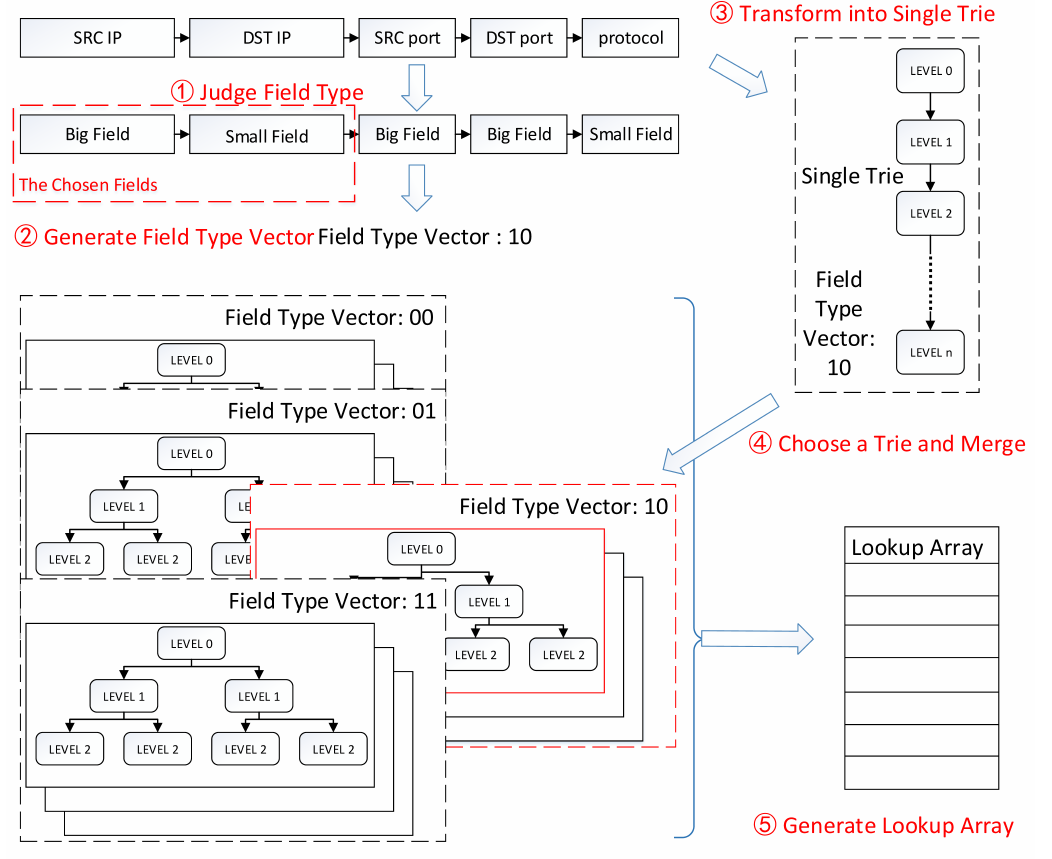
Figure 5. Insertion process with ruleset